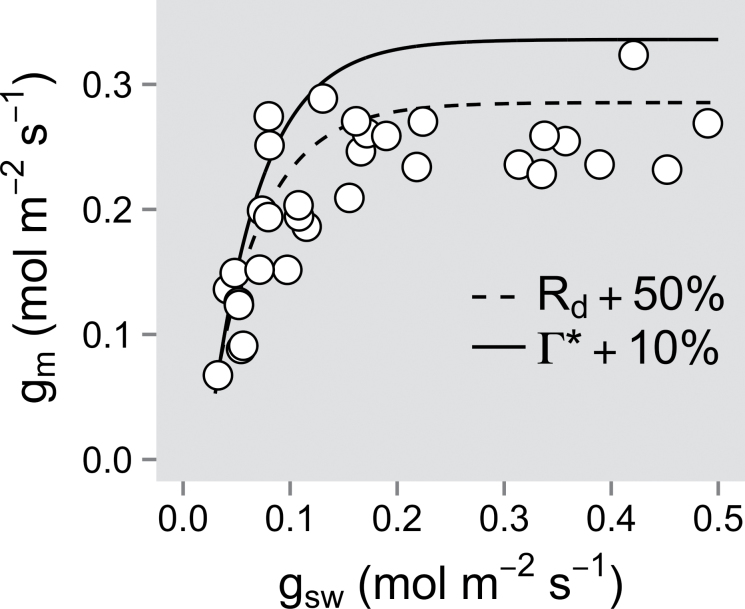
Sensitivity of mesophyll conductance (g
m) estimates to a 10% increase in chloroplastic CO2 photocompensation point (Γ*, solid line) or a 50% increase in non-photorespiratory mitochondrial respiration in the light (R
d, dashed line). Asymptotic fits of the simulated data were used to represent the observed variations. Data from Assiniboine in Fig. 3 were used (original data: open circles).